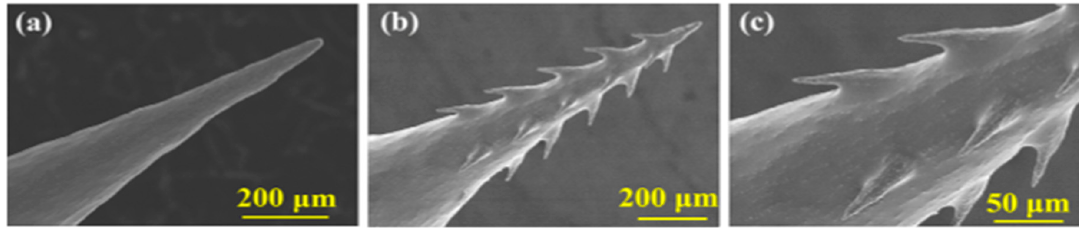
Figure 6. Imagesofthe( a )parentMN,( b )bioinspiredMN,and( c Figure 6. Images of the ( a ) parent MN, ( b ) bioinspired MN, and ( c ) barbs on the parent MN (adopted from [82]).